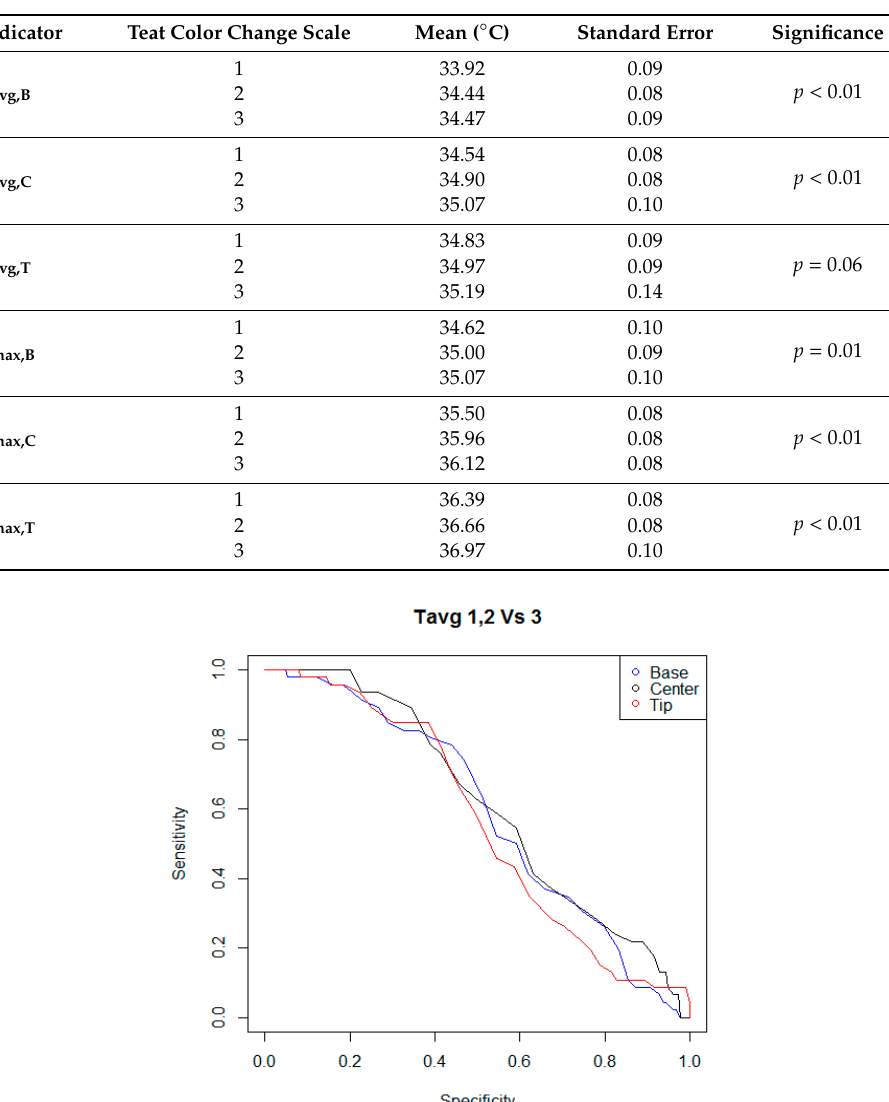
Table 1. Values of the indicators T avg,B , T avg,C , T avg,T , T max,B , T max,C , and T max,T for each level of the color change scale used to evaluate the teats after milking (means ± S.E.).